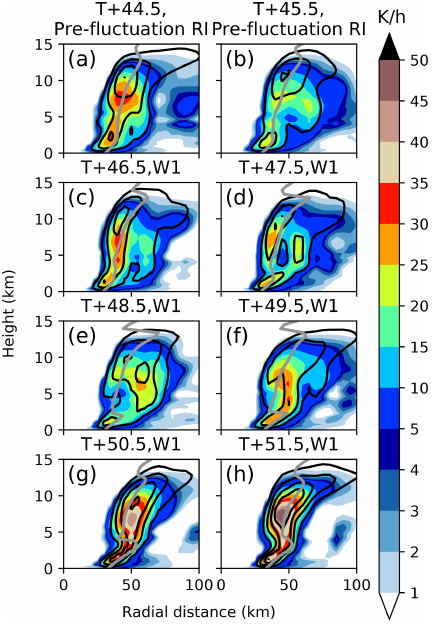
Figure 12. Diabatic heating (shading, Kh − 1 ) and vertical velocity (line contours) in intervals of 0.5ms − 1 before and during the first weakening phase W1. Also shown as a grey line is the height de- pendent RMW.